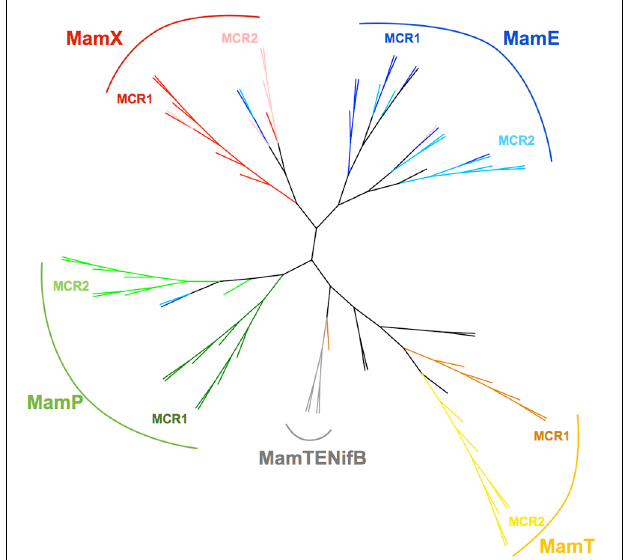
log likelihood (-1151.8298) is shown. The tree is drawn to scale, with branch lengths measured in the number of substitutions per site. The analysis involved 88 amino acid sequences. All positions containing gaps and missing data were eliminated. There were a total of 19 positions in the final dataset. Evolutionary analyses were conducted in MEGA5 (Tamura et al., 2011). Tree was edited and drawn with the interactive tree editor iTOL (Letunic and Bork, 2011). Color of the branches is according to the MCR domain position and the Mam protein it belongs to. For MCR 1 and MCR2 of MamE branches are respectively blue and light blue, MamP, green